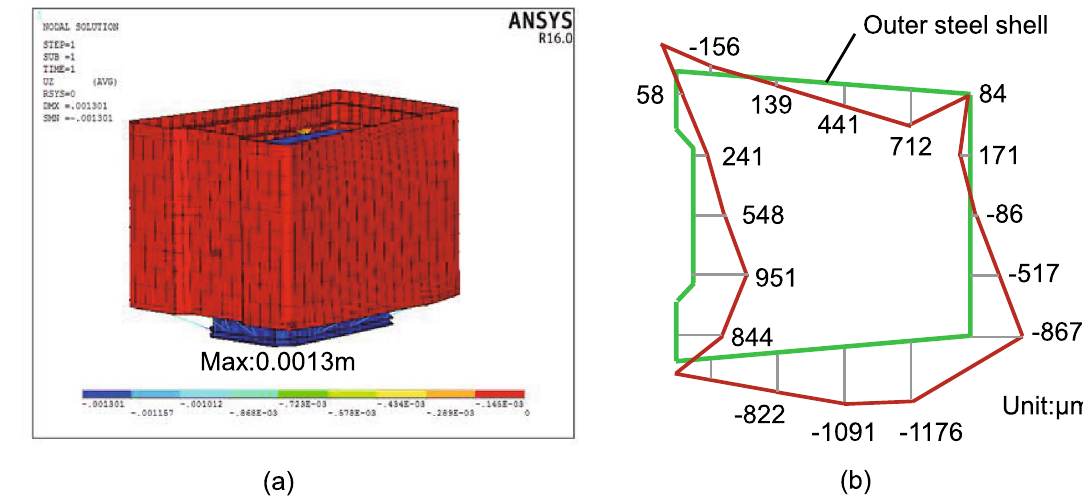
Figure 11. The deformation of steel shell: ( a ) the finite element analysis results of hoisting; ( b ) the welding deformation of the top